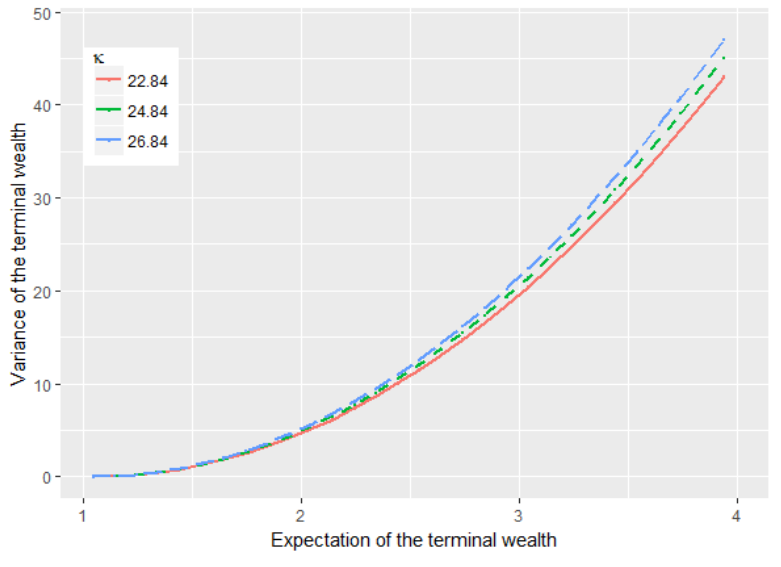
Figure 2. The impact of µ on the efficient frontier.